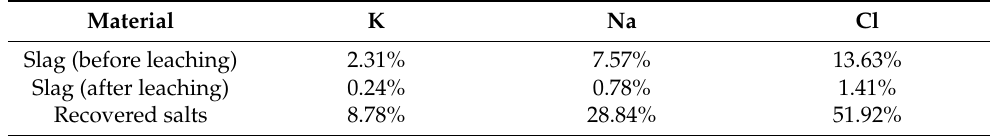
Table 5. Concentration (mass %) of K + , Na + , and Cl − in the obtained products. The maximum relative standard deviation was ± 2.19% and occurred for Na + analysis in the recovered salt. Material K